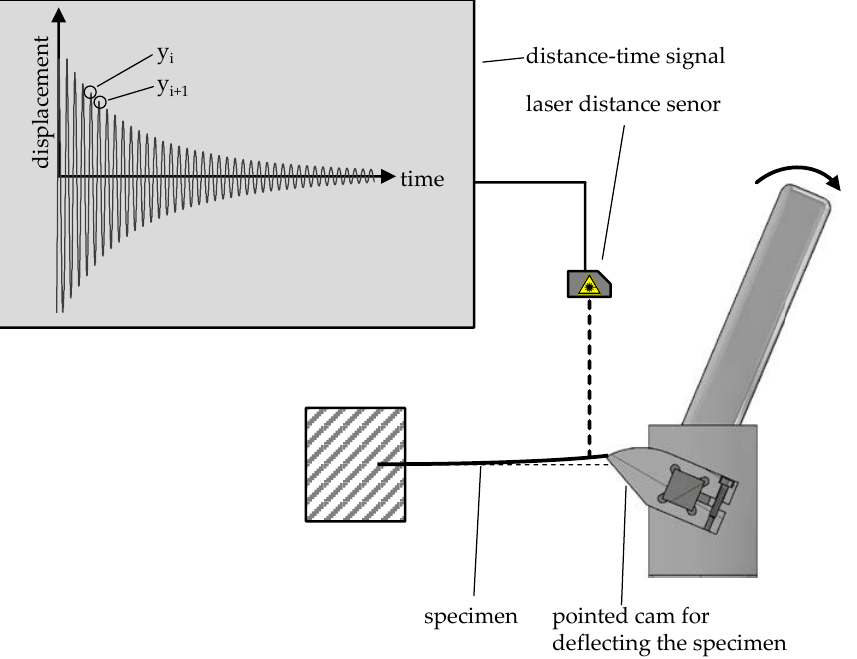
Figure 4. Apparatus for measuring material damping.